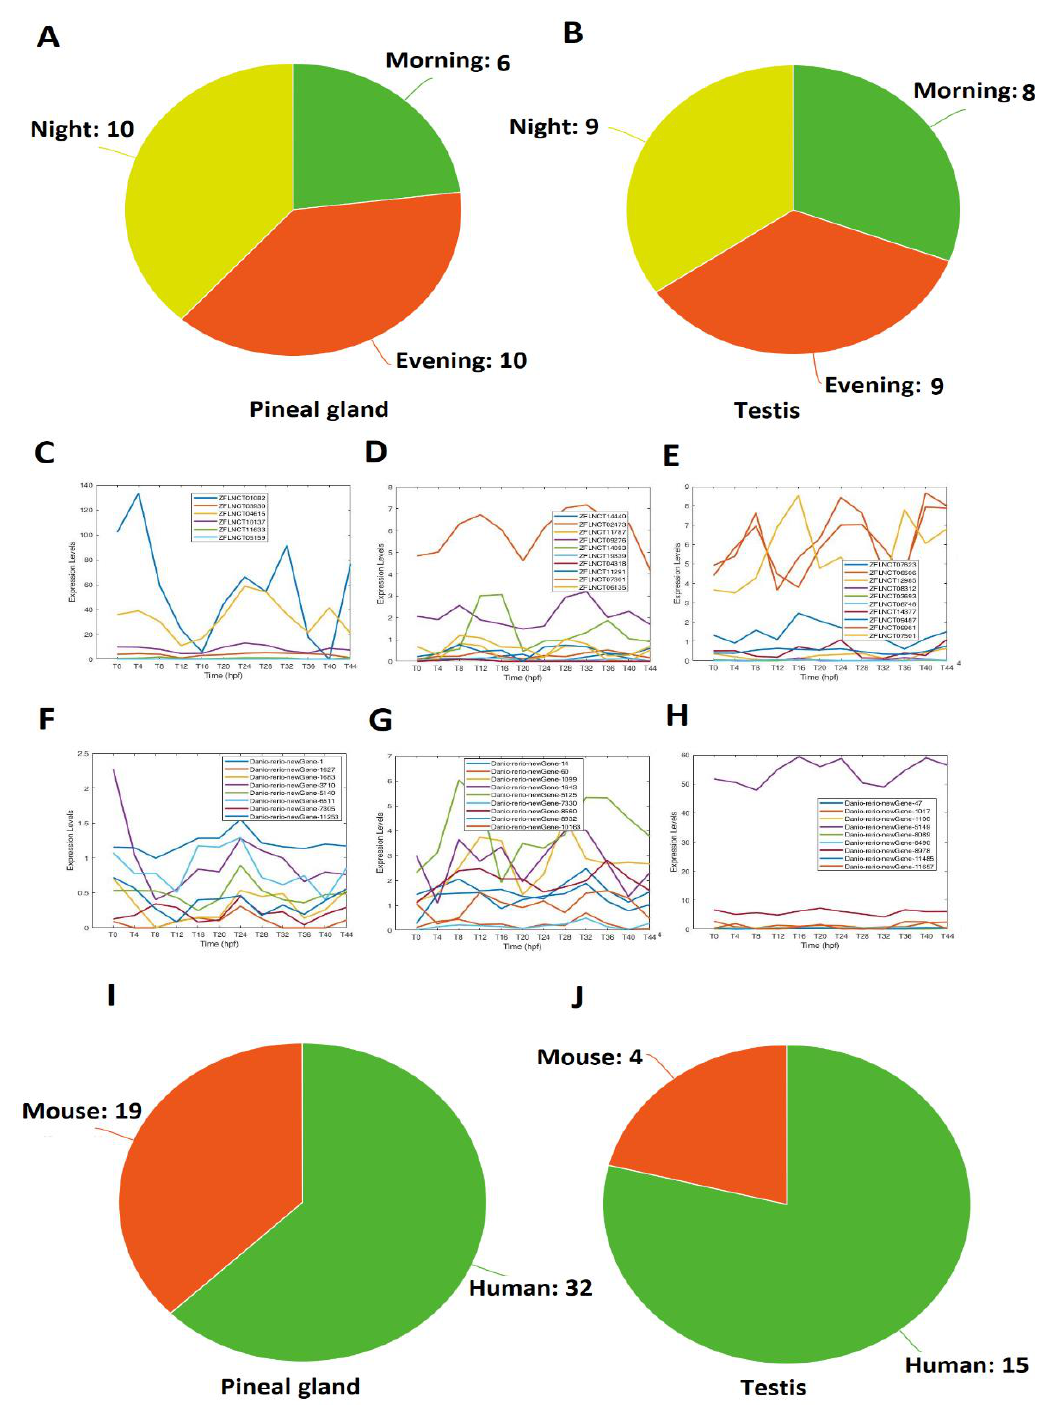
Figure 5. Overlapping lncRNAs between the pineal gland and testis ( A – H ), and conserved lncRNAs shared by zebrafish, mice, and humans ( I , J ). Fourteen lncRNAs with high similarity between the pineal gland and testis grouped into morning, evening, and night lncRNAs ( A , B ). Expression profiles of representative lncRNAs ( C – H ): 5 pineal gland morning lncRNAs ( C ), 4 pineal gland evening lncRNAs ( D ), 5 pineal gland night lncRNAs ( E ), 6 testis morning lncRNAs ( F ), 4 testis evening lncRNAs ( G ), and 4 pineal night lncRNAs ( H ). Conserved pineal gland ( I ) and testis ( J ) lncRNAs among zebrafish, mice, and humans.